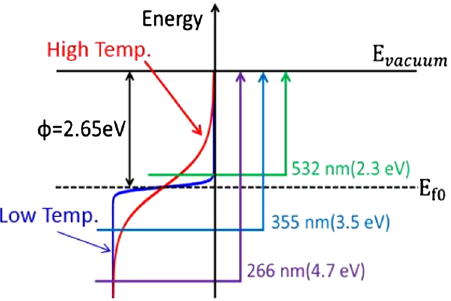
FIG. 1. Energy diagram schematic of thermally assisted photo- emission